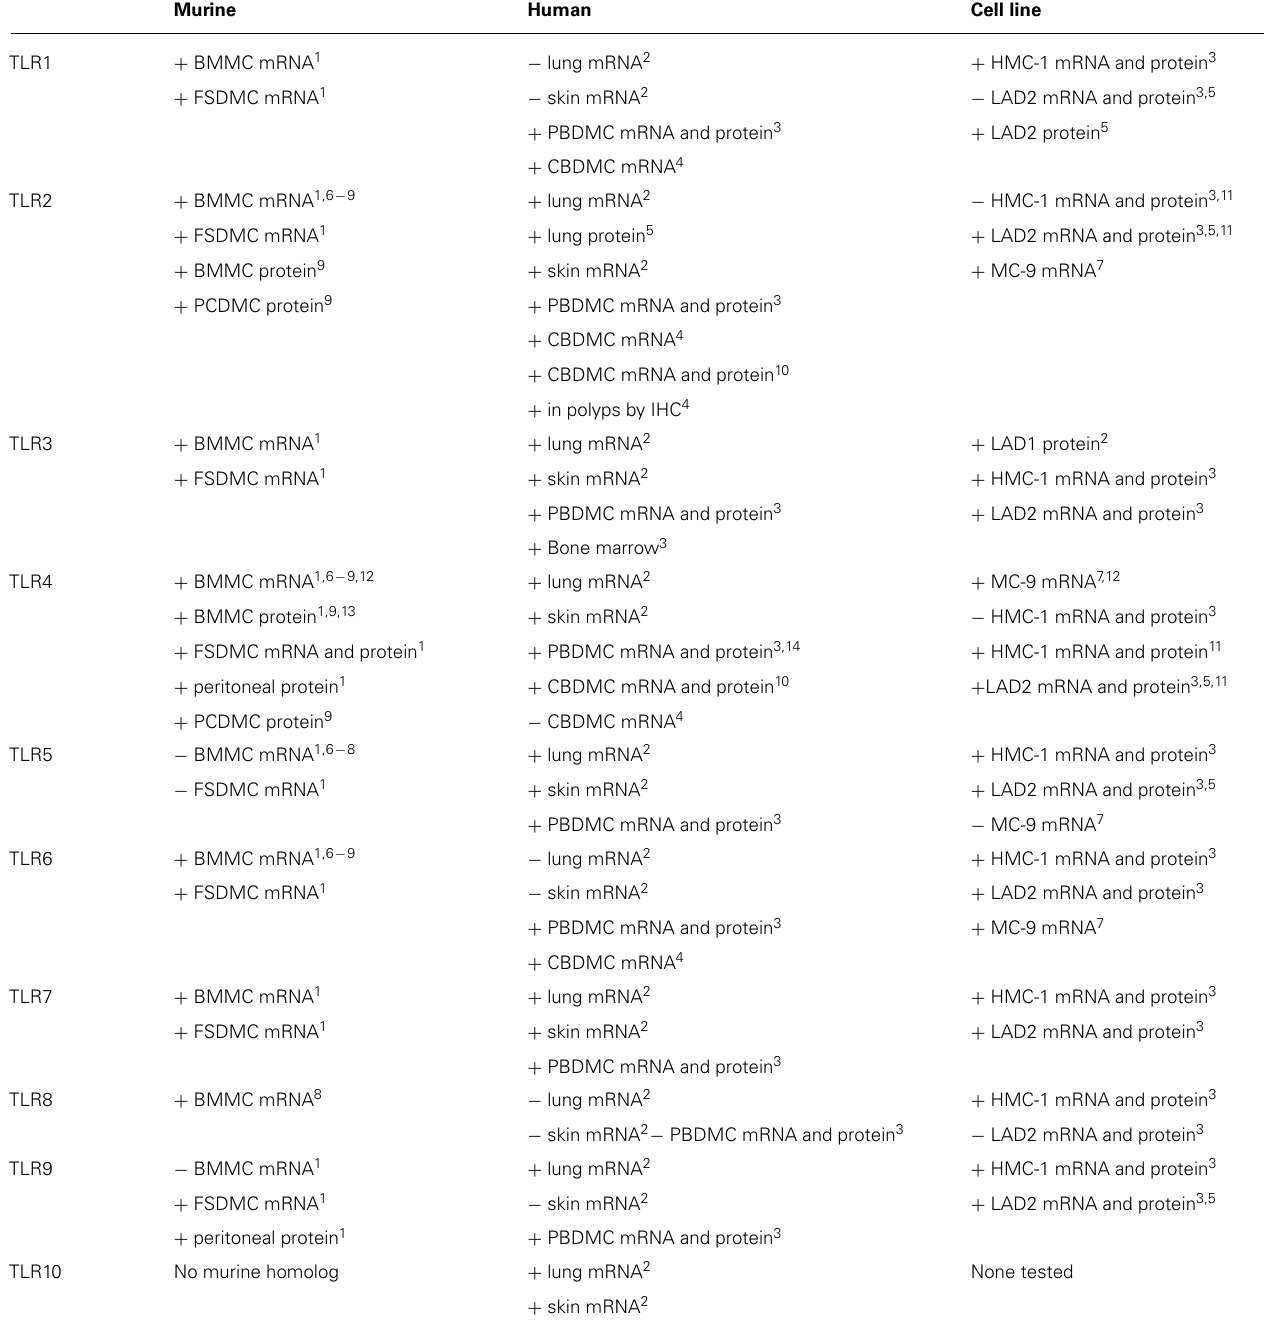
Table 2 |TLR expression by mast